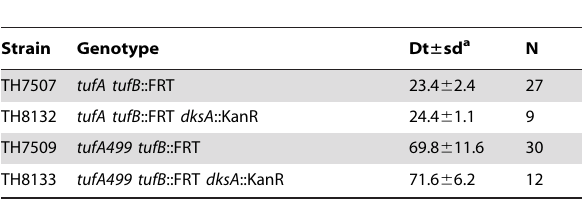
Table 2. Inactivating dksA does not compensate for tufA499